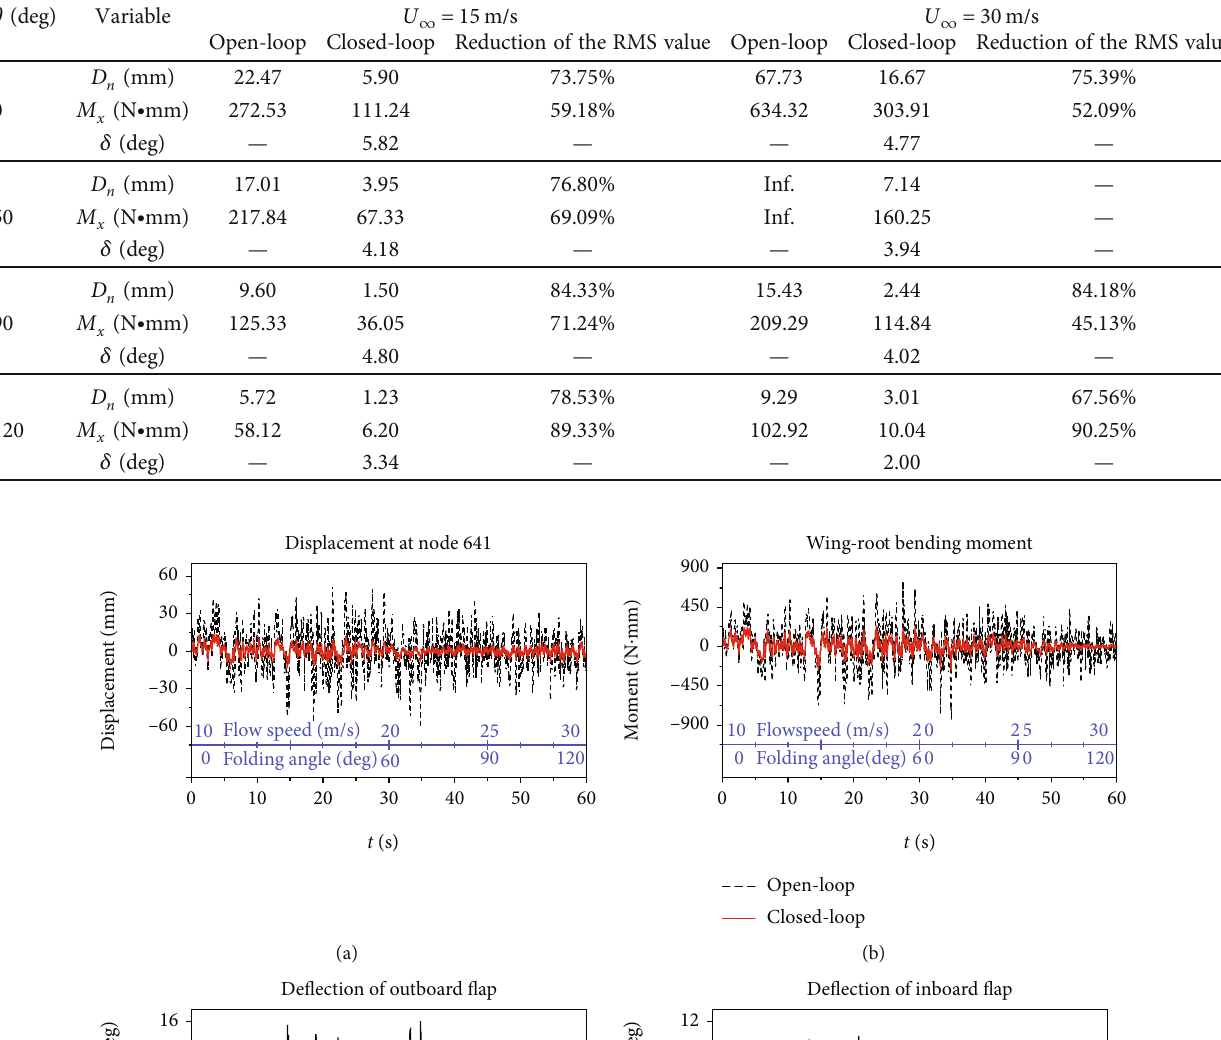
M fl ap de fl ection ( δ ) in continuous x ), and outboard